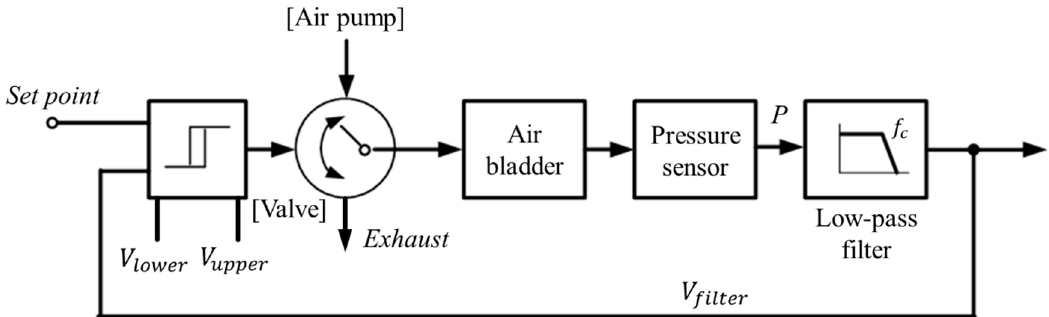
Figure 11. The hysteresis control algorithm with a closed loop.